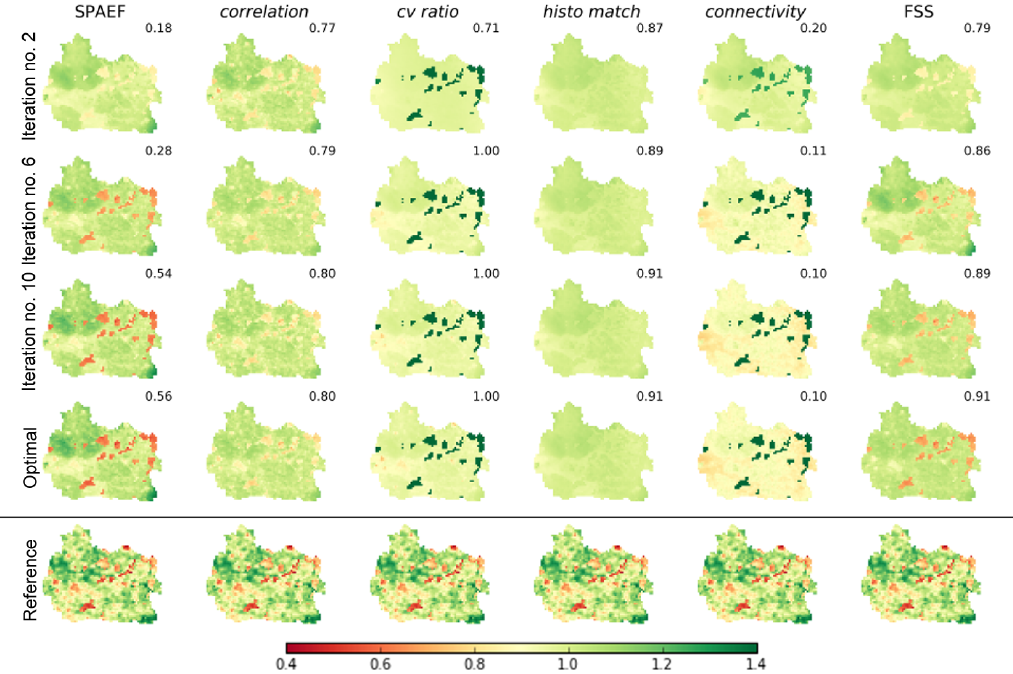
Figure 4. Tracking of the simulated actual evapotranspiration maps (normalized by mean) throughout the six conducted optimizations using different objective functions. The first four columns show the trajectory of pattern improvements in accordance with one objective function. The maps depict the best fit between the reference (b) and model at various iterations throughout the optimization. The spatial similarity scores in accordance with the different metrics are given in the top right corner of each